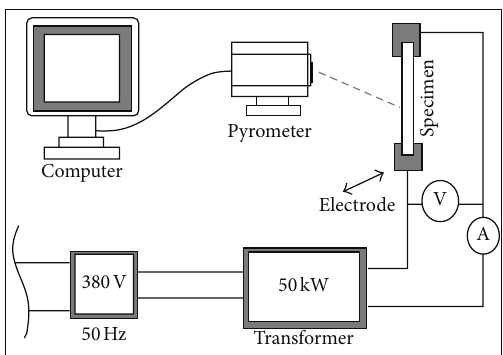
Figure 1: Schematic diagram of current heating test